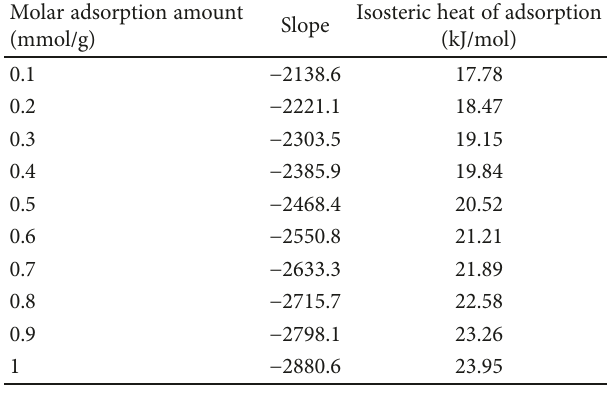
Figure 3: Relationship between pressures (logarithms) and molar adsorption